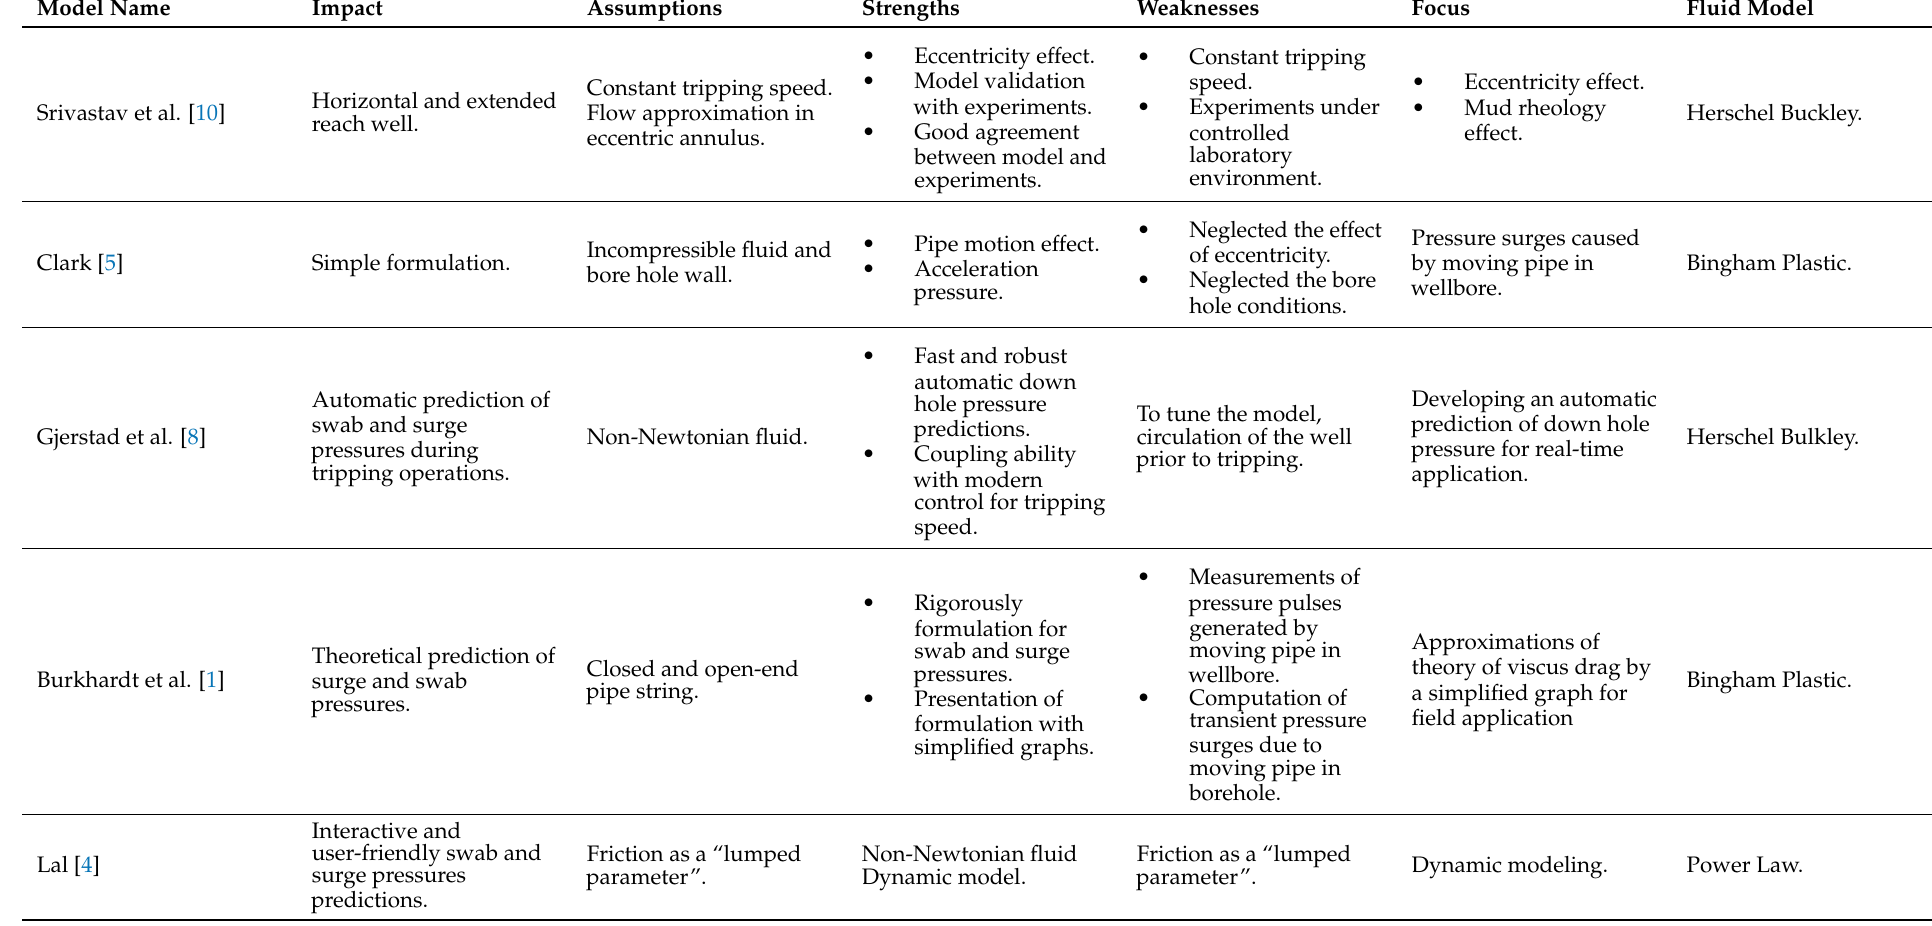
Table 5. Summary of five prominent works on the swab and surge pressure